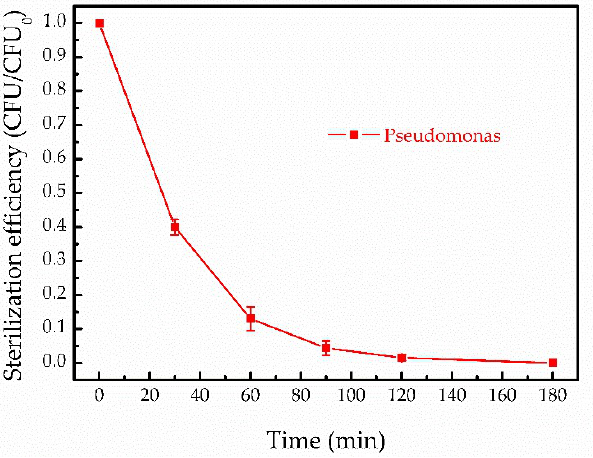
Figure 6. Inactivated effect of Fenton-like reaction on typical chlorine-resistant bacteria. Reaction conditions: [Goethite] = 0.89 g/L; [H 2 O 2 ] 0 = 0.50 g/L.